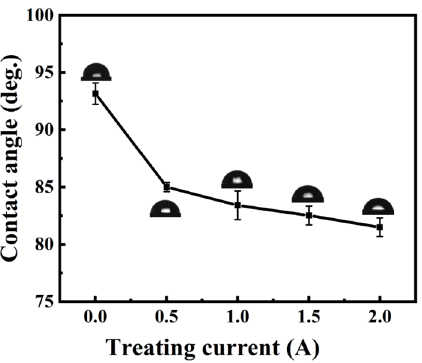
Figure 8. Contact angle of UHMWPE substrates treated with different carbon plasma currents.